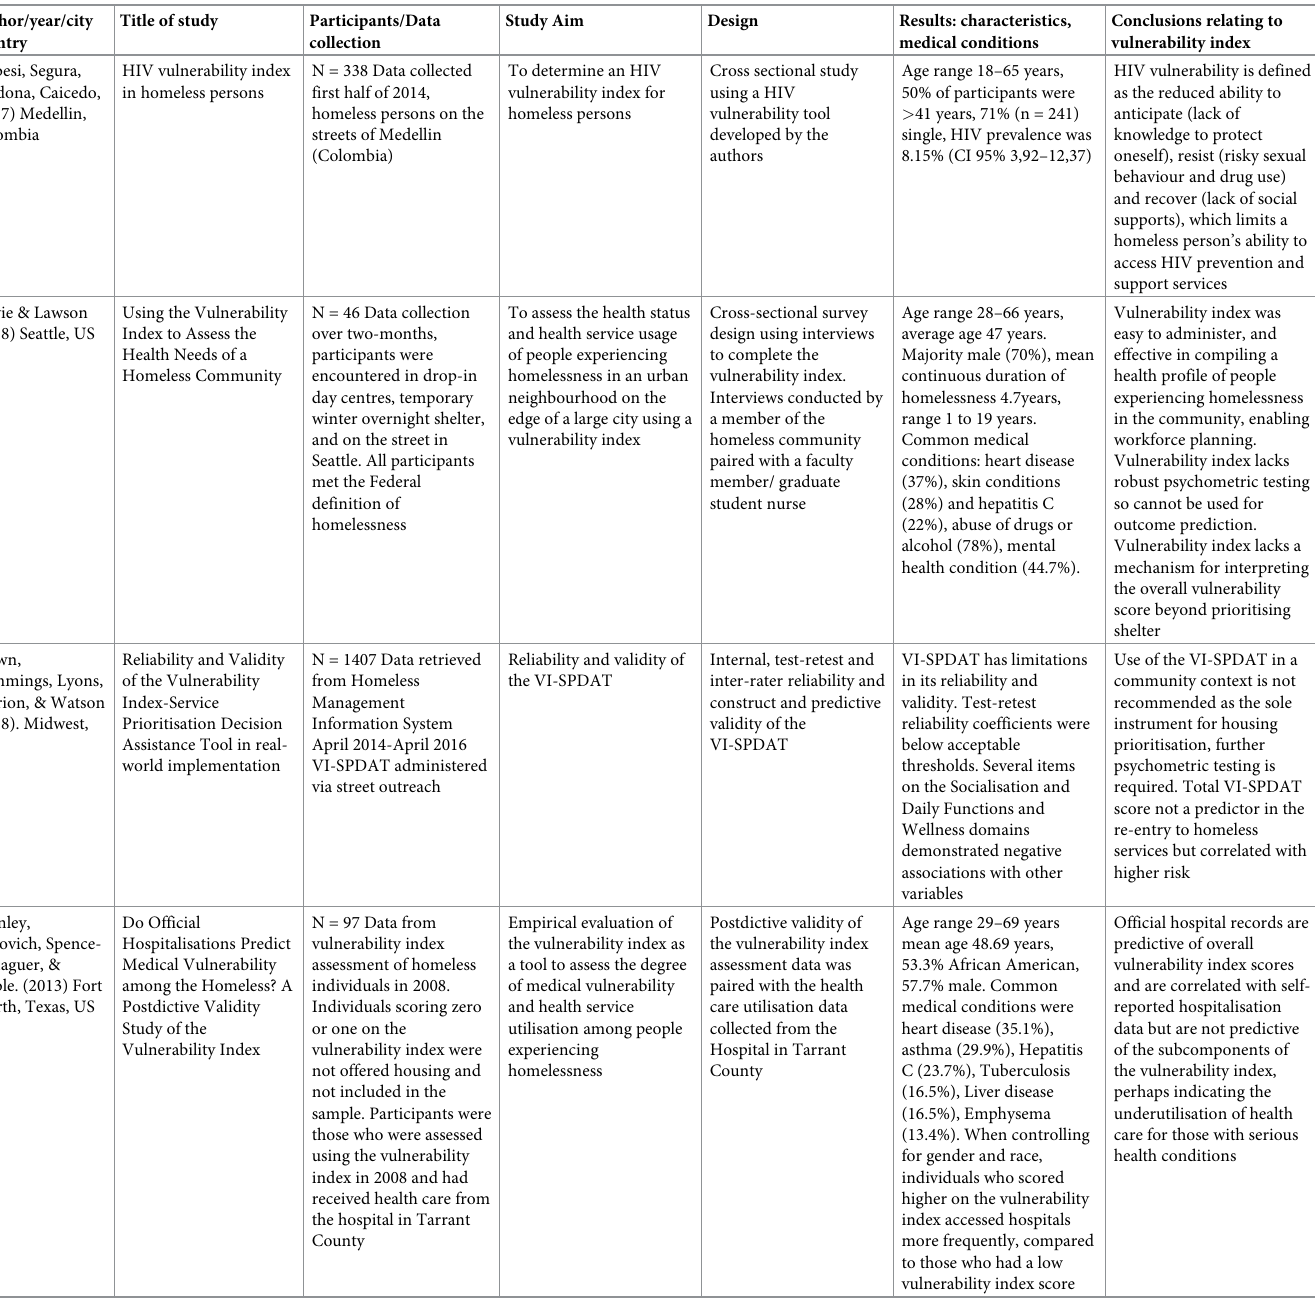
Table 3. Data charting vulnerability